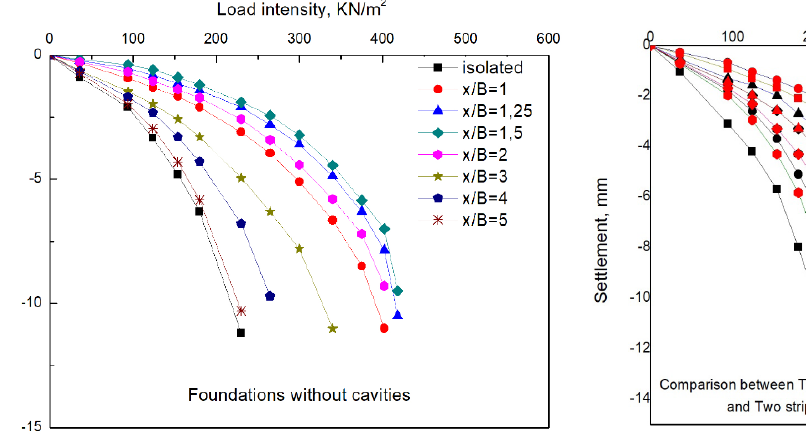
Figure 6: Load-settlement curve of adjacent footings without cavity and case of adjacent footings with cavity (H/B = 1).